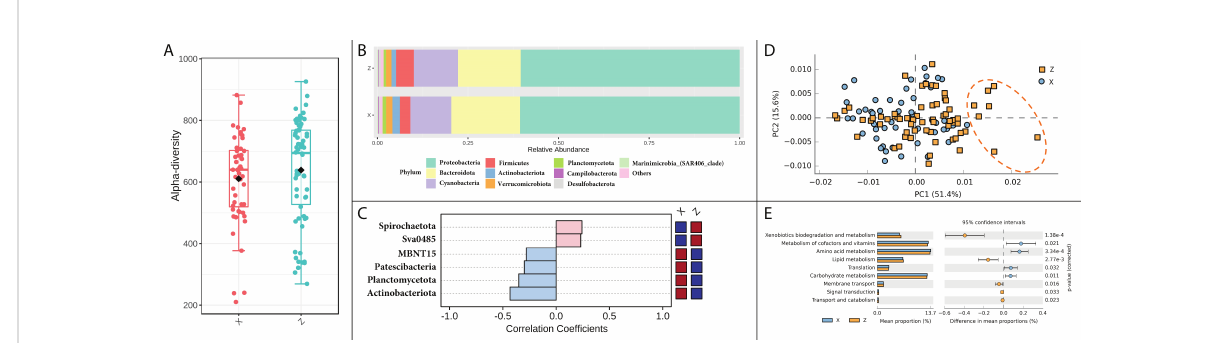
FIGURE 4 Spatial variation of bacterial community and function in shell fi sh farming areas. (A) Bacterial alpha diversity; (B) Bacterial relative abundance in phylum level; (C) The phyla in signi fi cantly spatial variation patterns. (D) Principal components analysis (PCA) of bacterial functional characterization; (E) The functional pathways in signi fi cantly spatial variation